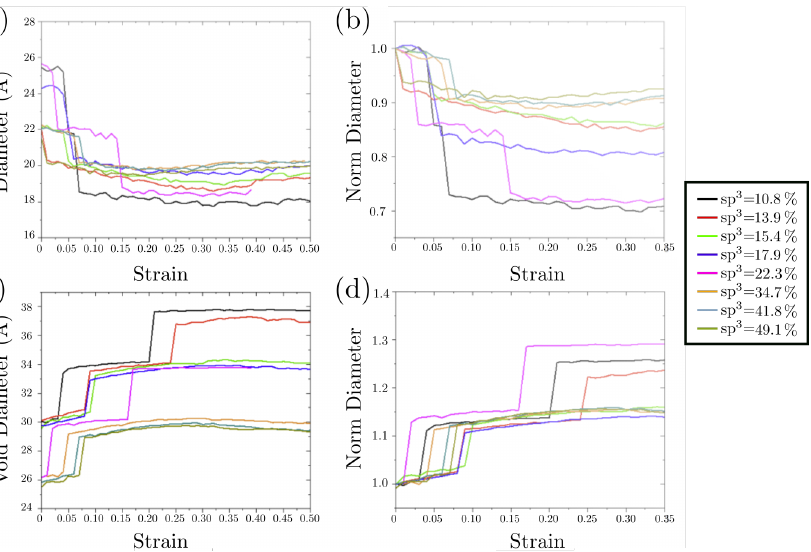
Figure 9. Ligament and ( a , c ) void diameters and the corresponding normalized diameters ( b , d ) for the simulated